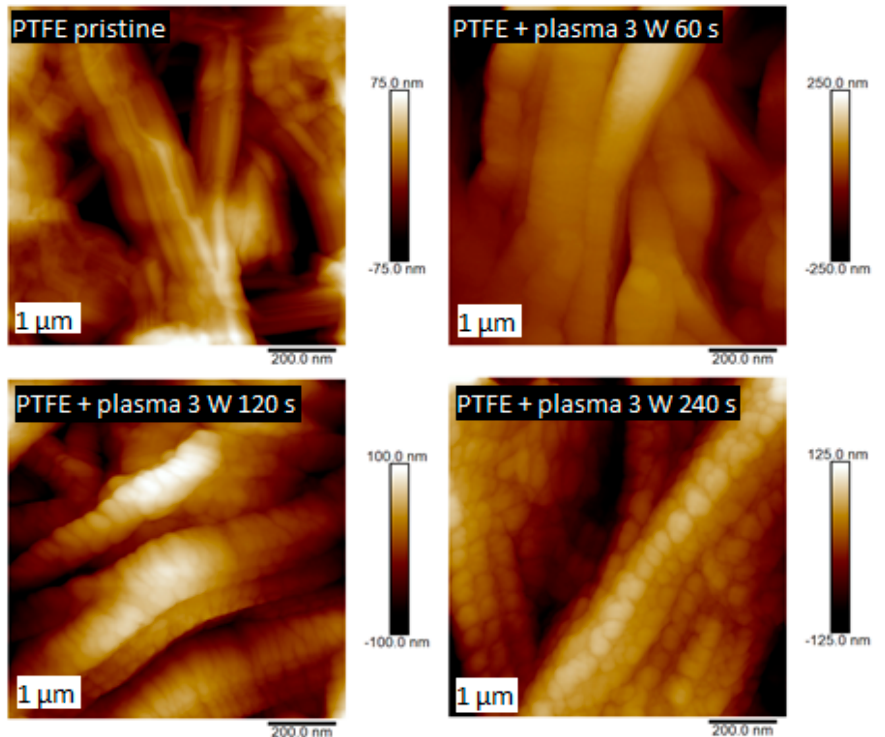
Figure 5. Surface morphology studied by AFM for pristine PTFE and PTFE treated by plasma at 3 W for 60, 120, and 240 s.